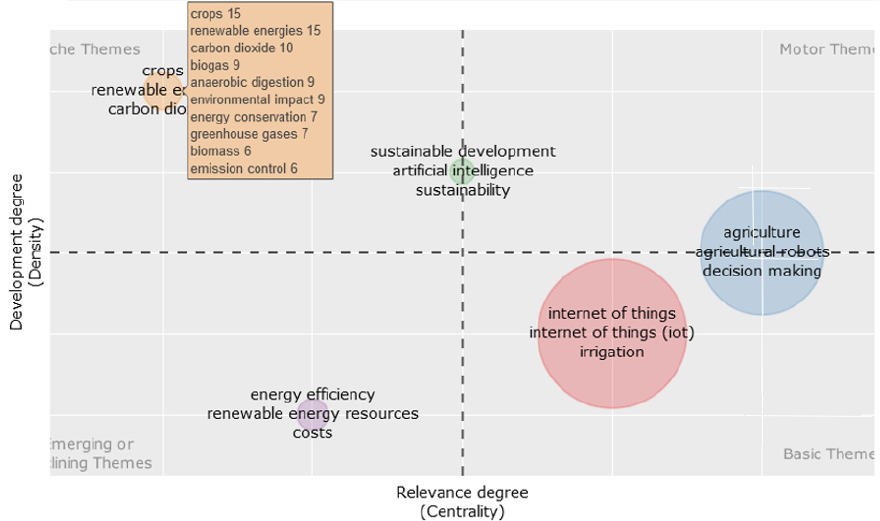
Figure 10. Thematic map of authors’ keywords. Source: Scopus/Biblioshiny.